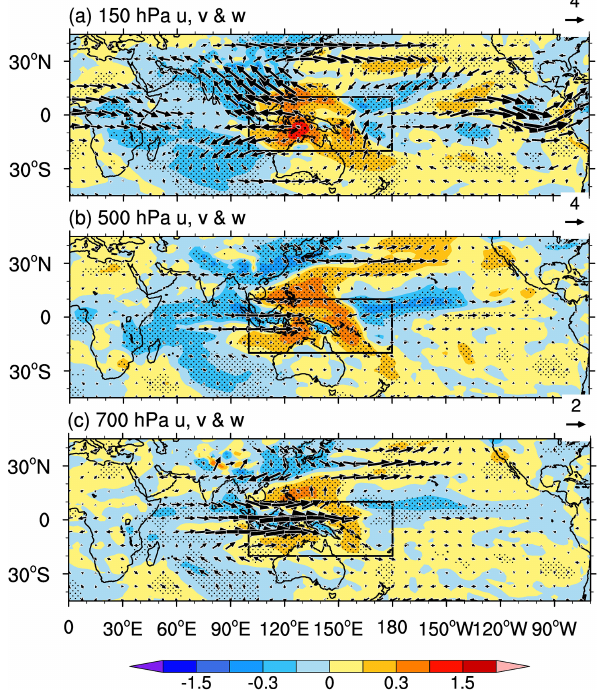
Figure 6. The difference in vertical velocity (shading; 10 − 2 ms − 1 ) and horizontal winds (arrows; ms − 1 ) at (a) 150hPa, (b) 500hPa, and (c) 700hPa in NDJFM between experiments R1 and R2. The differences between the vertical velocity over the dotted regions are statistically significant at the 95% confidence level. The black rect- angles denote the TWP region (20 ◦ S–10 ◦ N, 100–180 ◦ E).